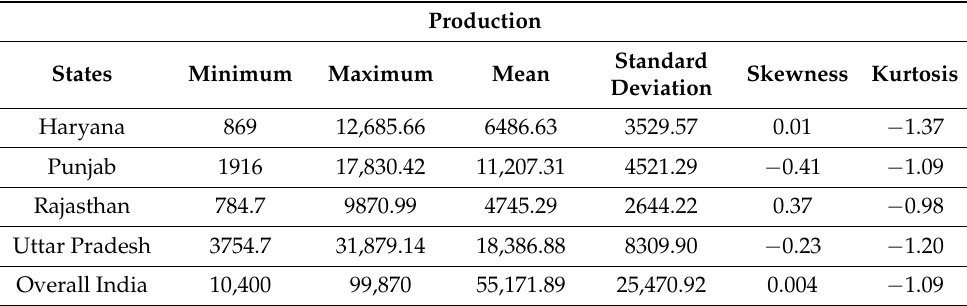
Table 8. Summary statistics of production of wheat (thousand